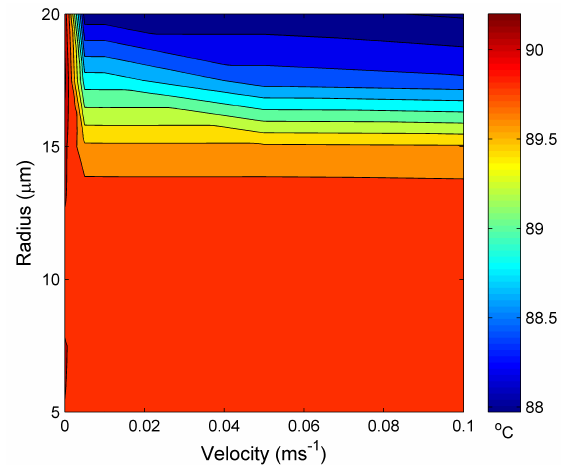
Figure 10. Calculated temperature at the steady state vs. the water hole radius and water input velocity at 90 ◦ C